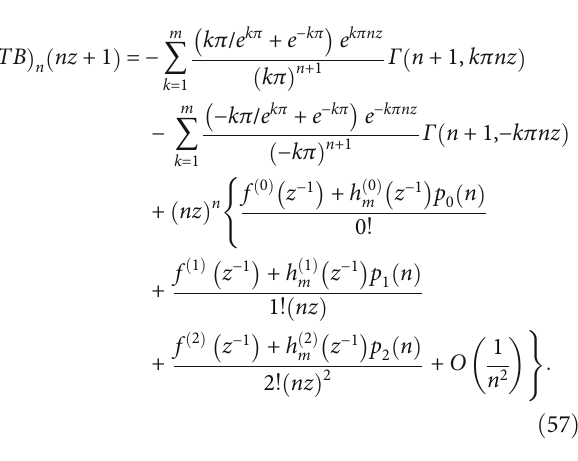
Figure 3: Solid lines represent T normalized by the factor ð 1 + j x / α j n Þ